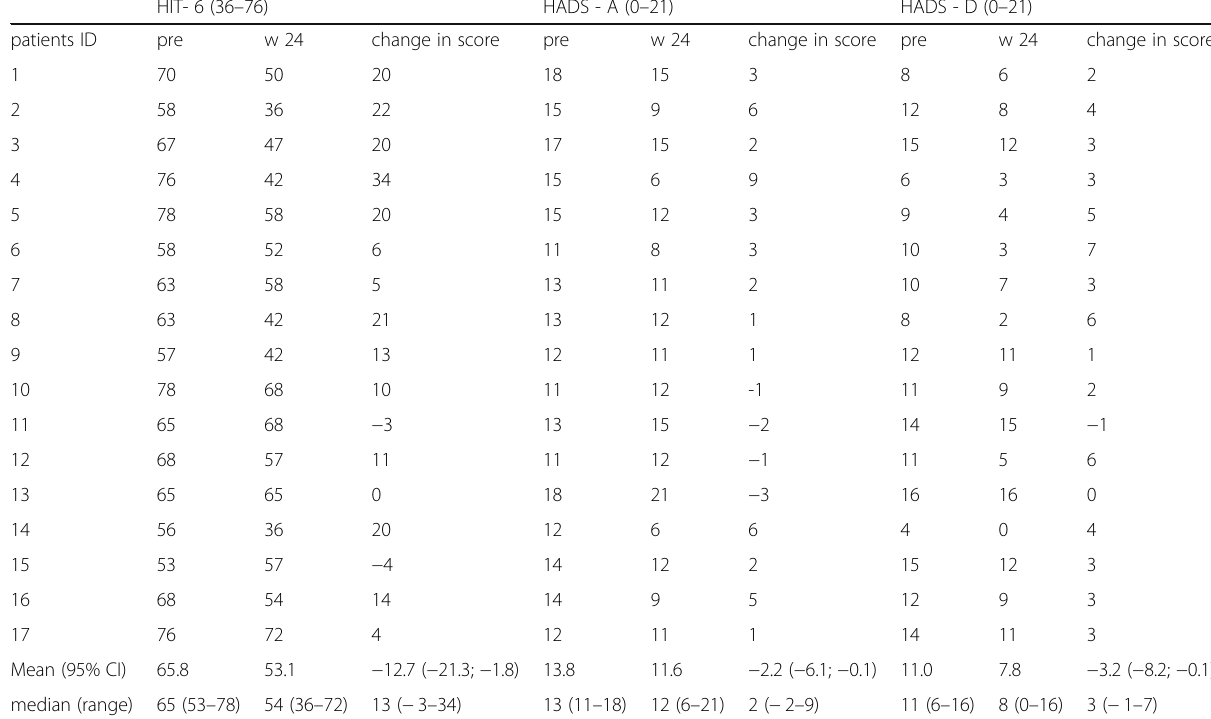
Table 3 Headache-associated disability scores pre- and post- treatment with OnabotulinumtoxinA HIT- 6 (36 –